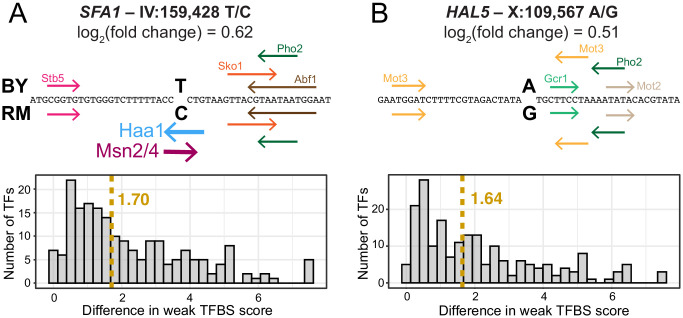
Examples of predicted TFBS changes at individual variants.(A) A variant in the promoter of the SFA1 gene alters a strong Msn2/4 motif (Yeastract consensus motif: CCCCT); as well as a strong Haa1 motif (SMGGSG). TFBSs detected by the Yeastract website in the given sequence are shown as colored arrows indicating the strand on which the motif match was detected. TFBSs above the sequence were detected for the BY allele, while those below the sequence were detected for the RM allele. Two TFBSs that differ between the alleles are shown as stronger lines. The histogram shows the distribution of change in TFBS score to weak TFBSs. The dashed yellow line indicates the median change in TFBS score. TFBS scores correspond to log2(predicted likelihood of binding). (B) A variant in the promoter of the HAL5 gene that did not alter strong TFBSs. Nevertheless, this variant caused a similar change in gene expression, accompanied by a similar median change to weak TFBSs, as the variant in (A).